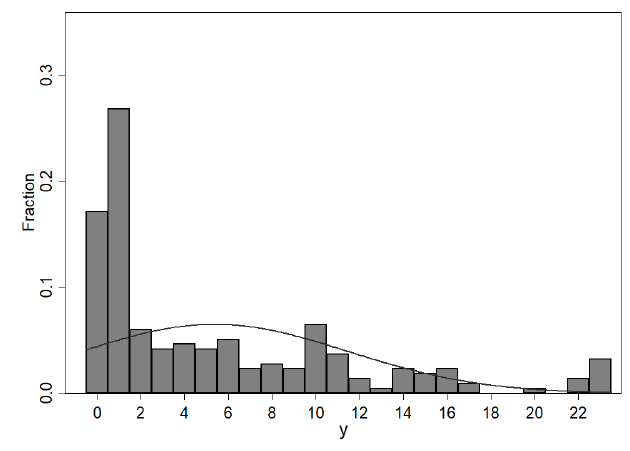
Figure 5. Distribution of average intended offer y .